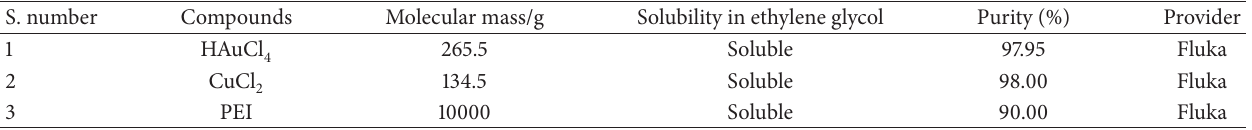
Table 1: Details of the chemicals